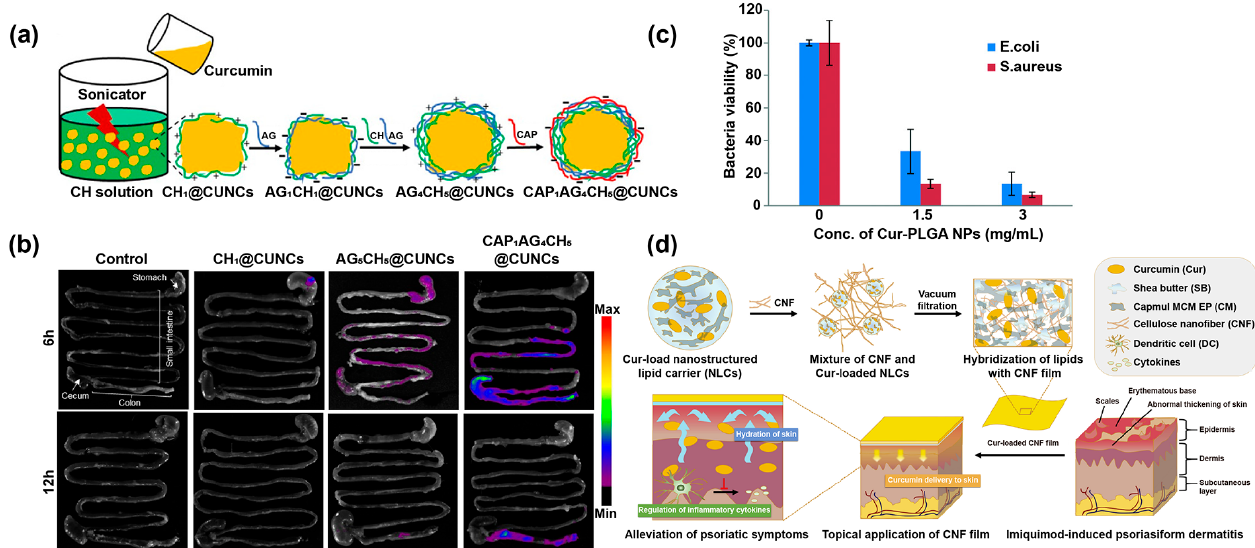
Figure 7. ( a ) Schematic diagram of the preparation of CAP 1 AG 4 CH 5 @CUNC. ( b ) The distribution of different NPs in the gastrointestinal tract of mice after 6 h or 12 h administration. Reproduced with permission [111], Copyright 2020, American Chemical Society. ( c ) Antimicrobial effect of Cur-PLGA NPs against E. coli and S. aureus . Reproduced with permission [112], Copyright 2019, Wiley-VCH. ( d ) Schematic illustration of the Cur-loaded lipid-hybridized CNF film for the treatment of IMQ- induced psoriasiform dermatitis. Reproduced with permission [113], Copyright 2018,